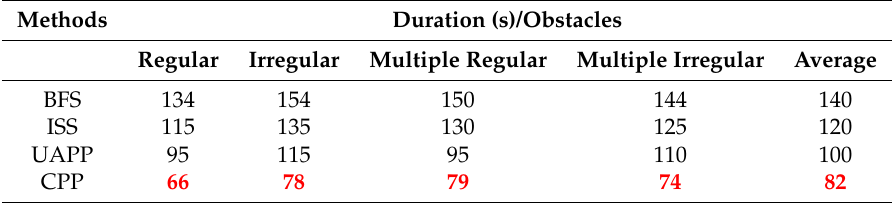
Table 7. A comparative analysis of the duration time to traverse the operational environment.